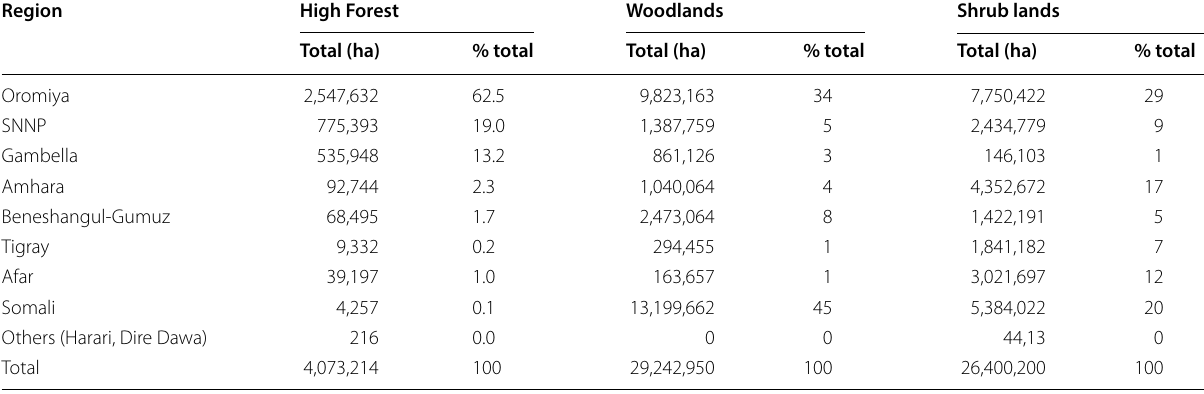
Source: WBISPP (2004)